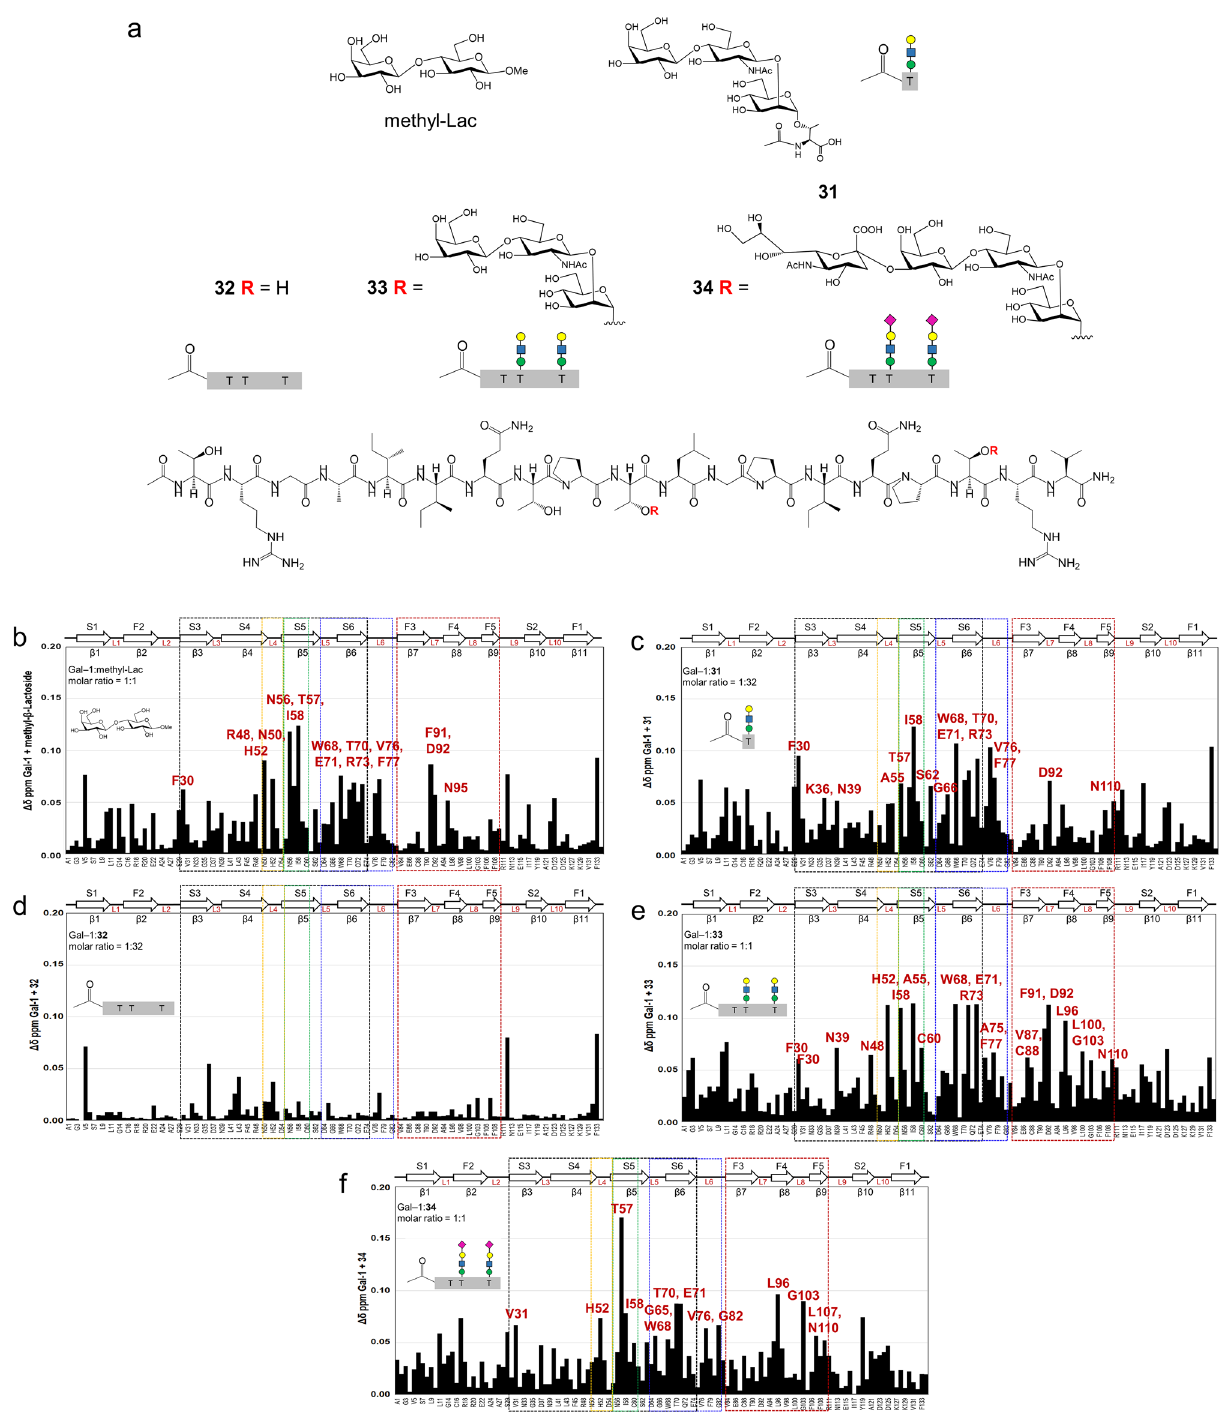
Figure 6. Structure of methyl-Lac, 31 , 32 , 33 , and 34 used for 1 H- 15 N HSQC NMR studies ( a ). Chemical shift map (Δδ vs. sequence of Gal-1) is shown for methyl-Lac ( b) , glyco-amino acid 31 ( c ), unglycosylated α-DG glycopeptide 32 ( d ), LacNAc-terminated glycopeptide 33 ( e ), sialyl-LacNAc-terminated glycopeptide 34 ( f ). Chemical shift differences (Δδ) were calculated as [(Δ 1 H) 2 + (0.25Δ 15 N) 2 )] 1/2 . Solution condition were 20 mM potassium phosphate buffer, pH 6.9, 50 μM EDTA, with 10 mM DTT made up using a H 2 O/D 2 O